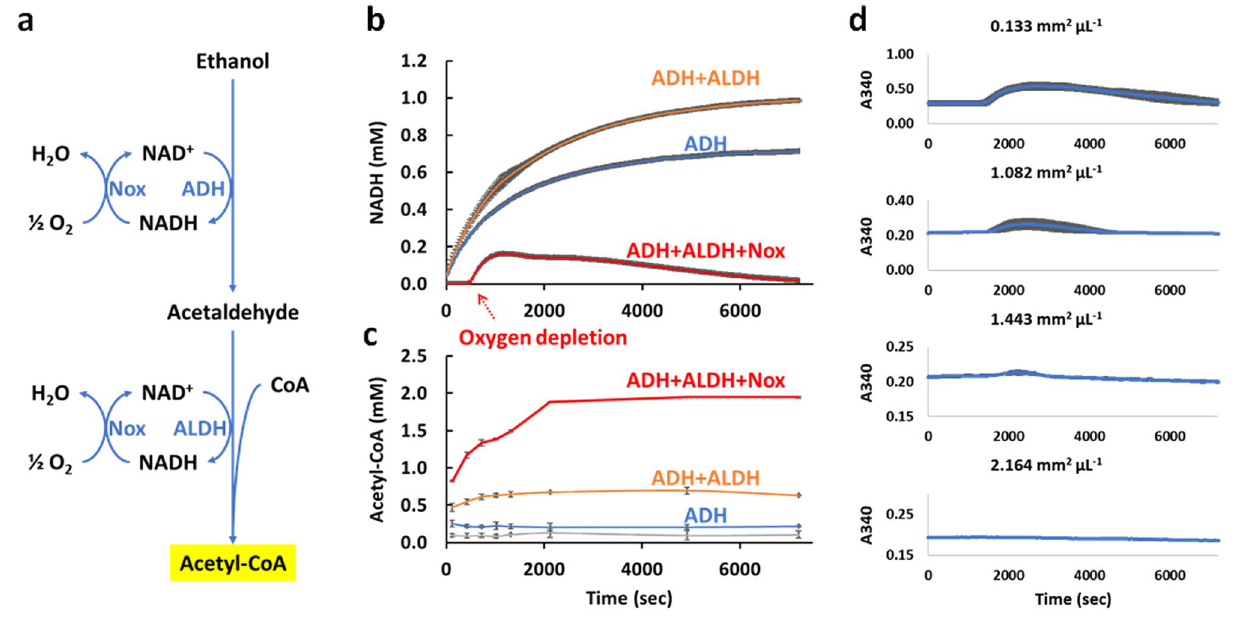
Figure 2. Ethanol to acetyl-CoA module. ( a ) Schematic of the pathway employed. Reoxidation of NADH, catalyzed by Nox, maintains a concentration gradient to drive the otherwise thermodynamically unfavorable reaction. ( b ) NADH concentration over time with different enzyme combinations as indicated in the figure. ( c ) Acetyl-CoA concentration over time with different enzyme combinations as indicated in the figure. ( d ) The effect of surface area to volume on NADH concentrations over time, using the full system with ADH, ALDH and Nox. All assays experiments were performed in biological triplicates and the error bars reflect the standard